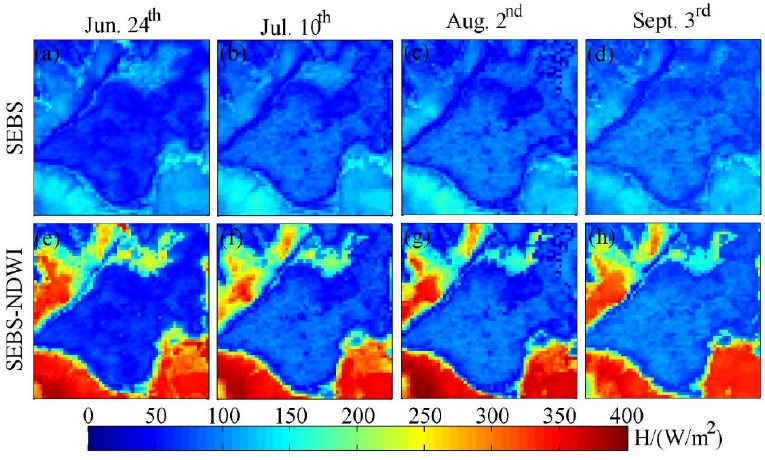
Figure 6. Instantaneous sensible heat flux maps of the study area in 2012. Figure 6 shows the